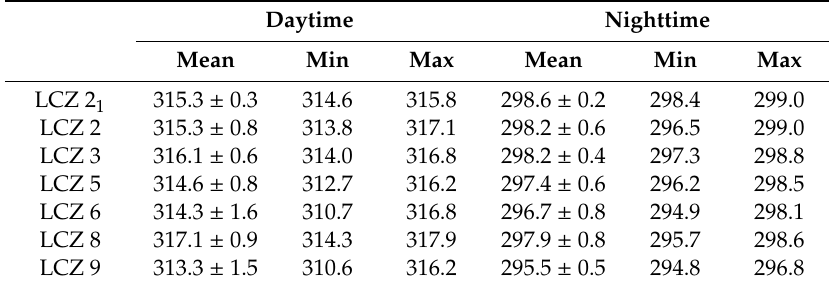
Figure 8. Spatial distribution of the average MODIS–LST (AQUA) in Athens for June–August 2017, ( a ) ≈ 14.30 local time and ( b ) ≈ 02.30 local time. Table 9. Mean ( ± one standard deviation), minimum and maximum land surface temperature (degrees Kelvin) for remotely-sensed MODIS–AQUA in Athens per LCZ (June–August 2017).